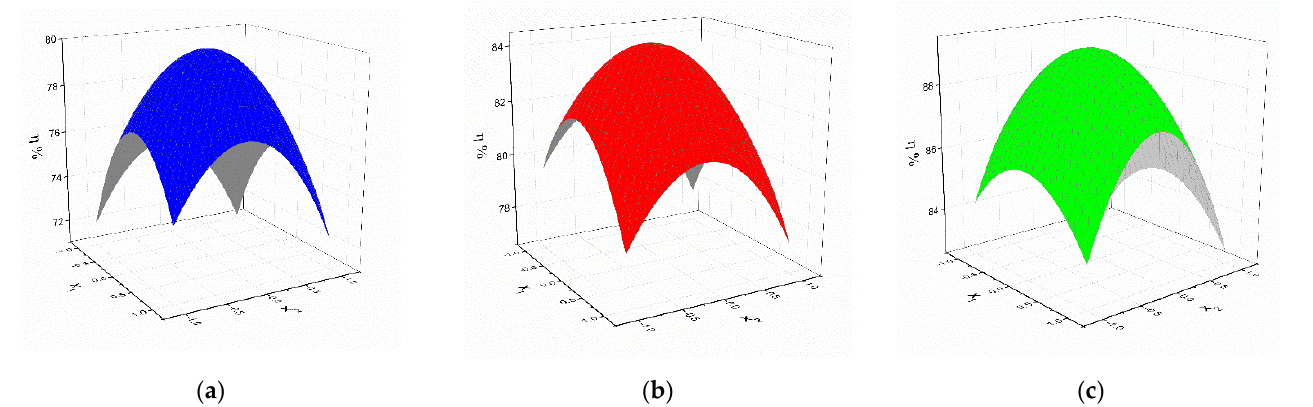
Figure 3. Dependence of the reaction’s yield on the dimensionless variables in optimization process of reactions from Scheme 5. for the compounds: ( a ) V ; ( b ) VI ; ( c ) VII .